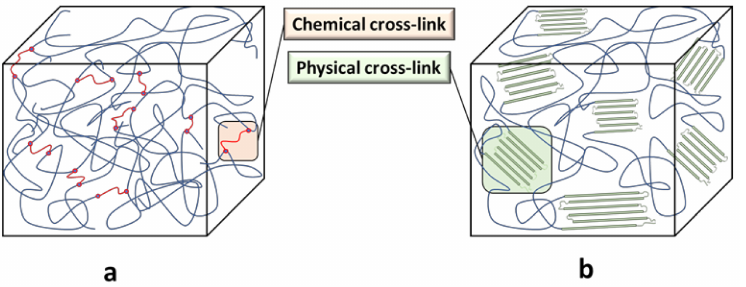
Figure 3. Chemical cross-linked elastomer ( a ) and physical networks in TPEs structure ( b